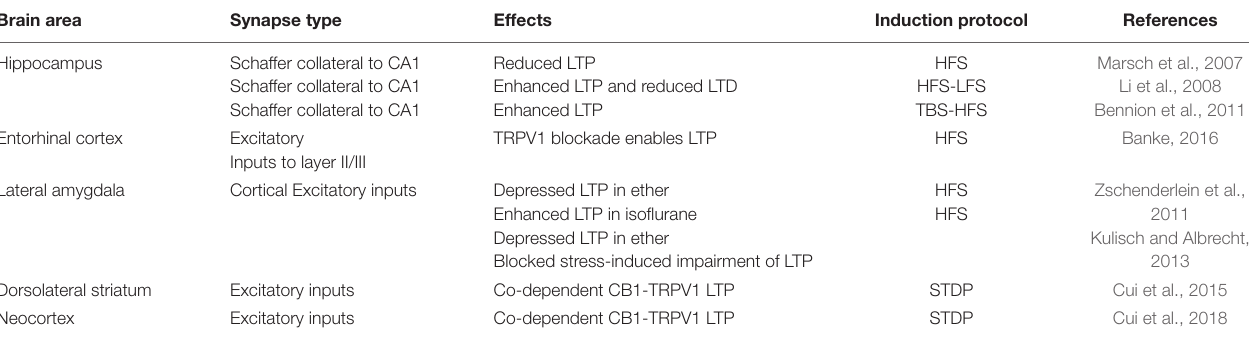
TABLE 2 | TRPV1 metaplasticity in the mammalian